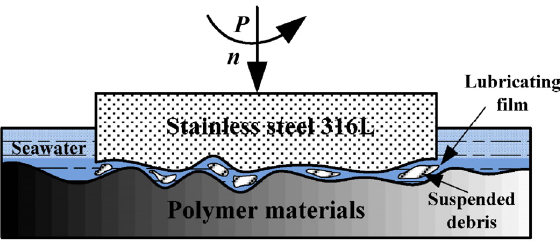
Fig. 8 Model of the beneficial effect of debris and